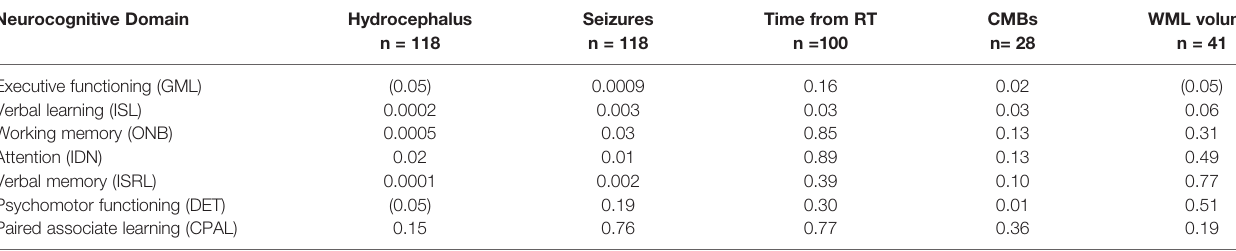
TABLE 3 | Patient and imaging characteristics associated with domains of neurocognitive outcomes. Neurocognitive Domain